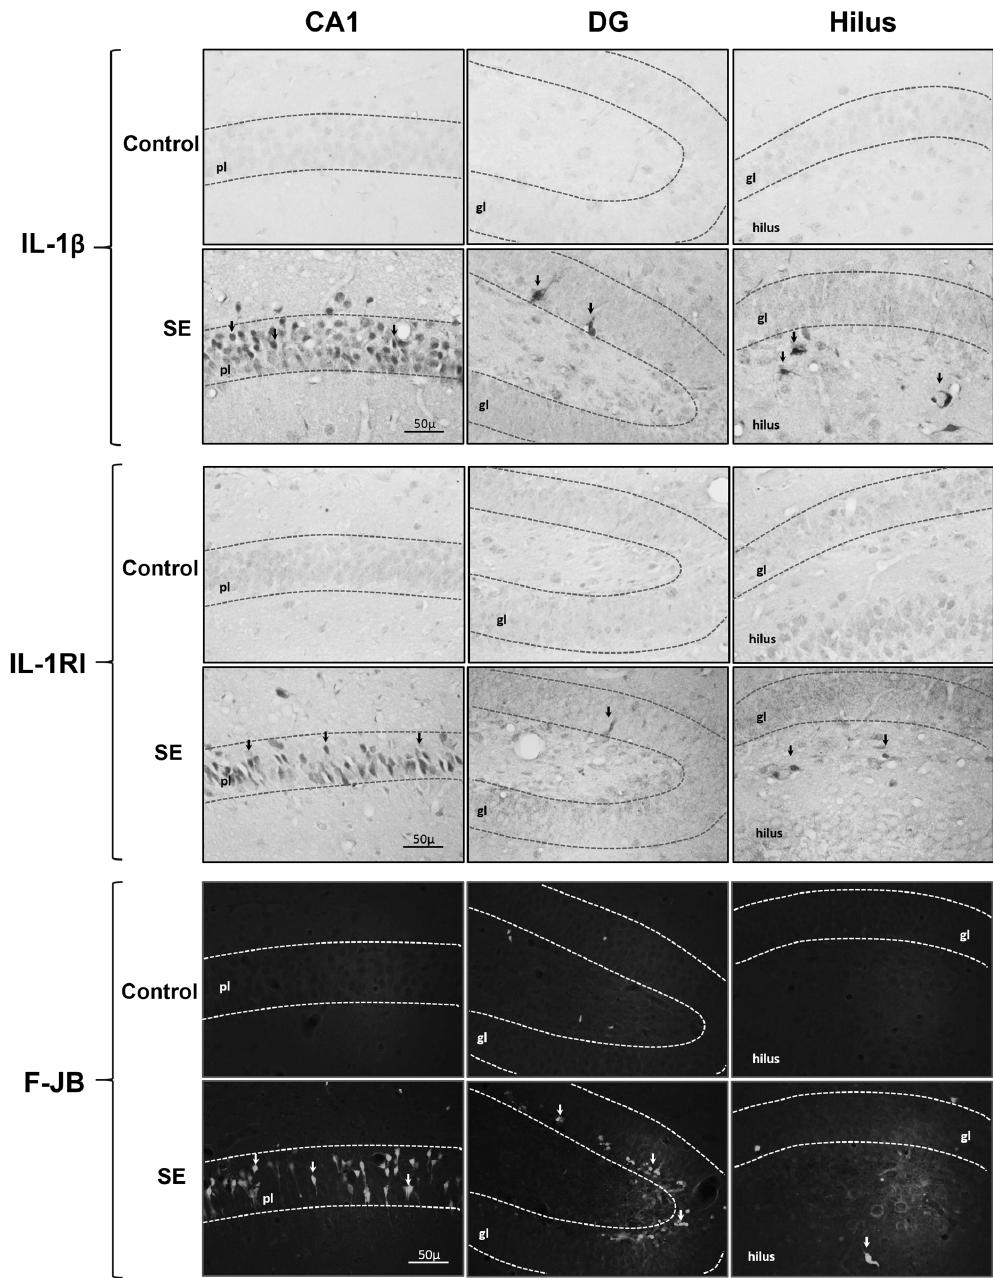
Figure 3 - Images of Interleukine-1 β (IL-1 β ), type 1 IL-1 receptor (IL-1RI) and Fluoro-Jade B (F-JB) positive cells in the CA1 pyramidal layer, dentate gyrus (DG) granule cell layer and hilus from dorsal hippocampus in control conditions and 6 h following status epilepticus (SE). Arrows point immunoreactive (dark cells) or F-JB positive cells (white cells) in every hippocampal area 6 h following SE. Control hippocampus does not show immunoreactive or injured cells. Abbreviations: pl, pyramidal layer, gl, granule cell layer. Scale bars = 50 μ